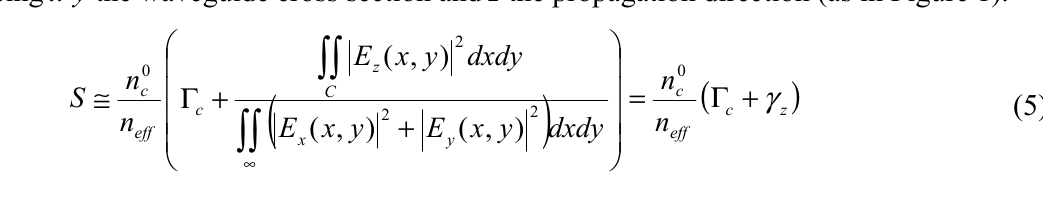
and t are silicon etching residues 1 2